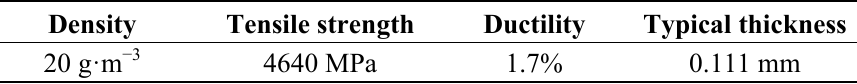
Table 4. The typical mechanical parameters for